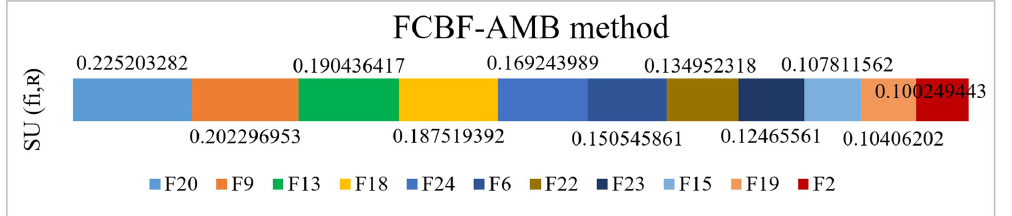
Figure 8. Initial bearing degradation indicator subset F ∗ .